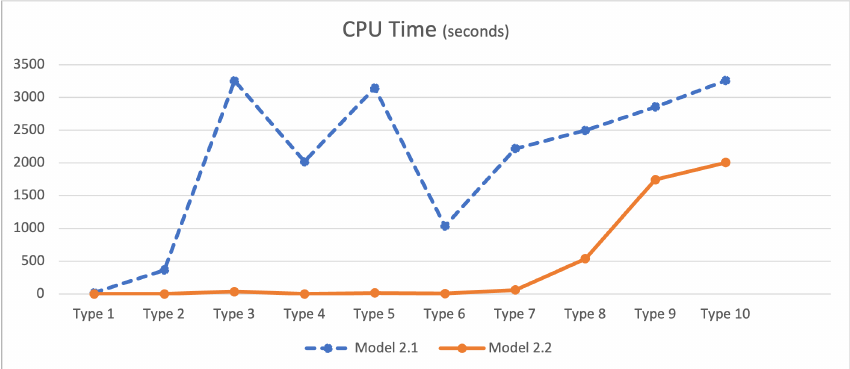
Figure 2. Comparison of the CPU time required by the model and the whole exact approach.